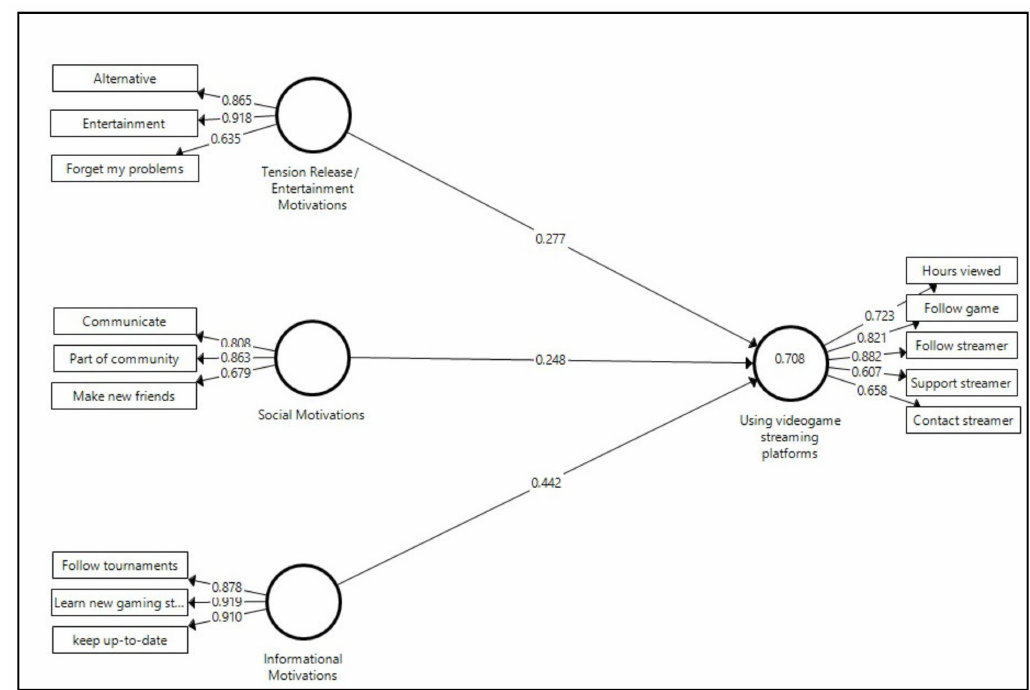
Figure 2. Estimated structural model. p < 0.01 for all the parameters; SRMR = 0.099.